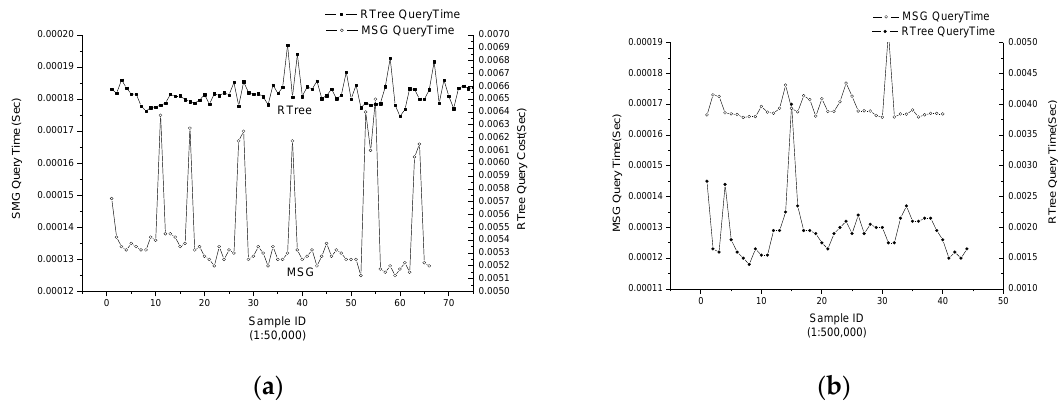
Figure 8. Number of the searched links of the hierarchical shortest-path algorithm (RHSP).